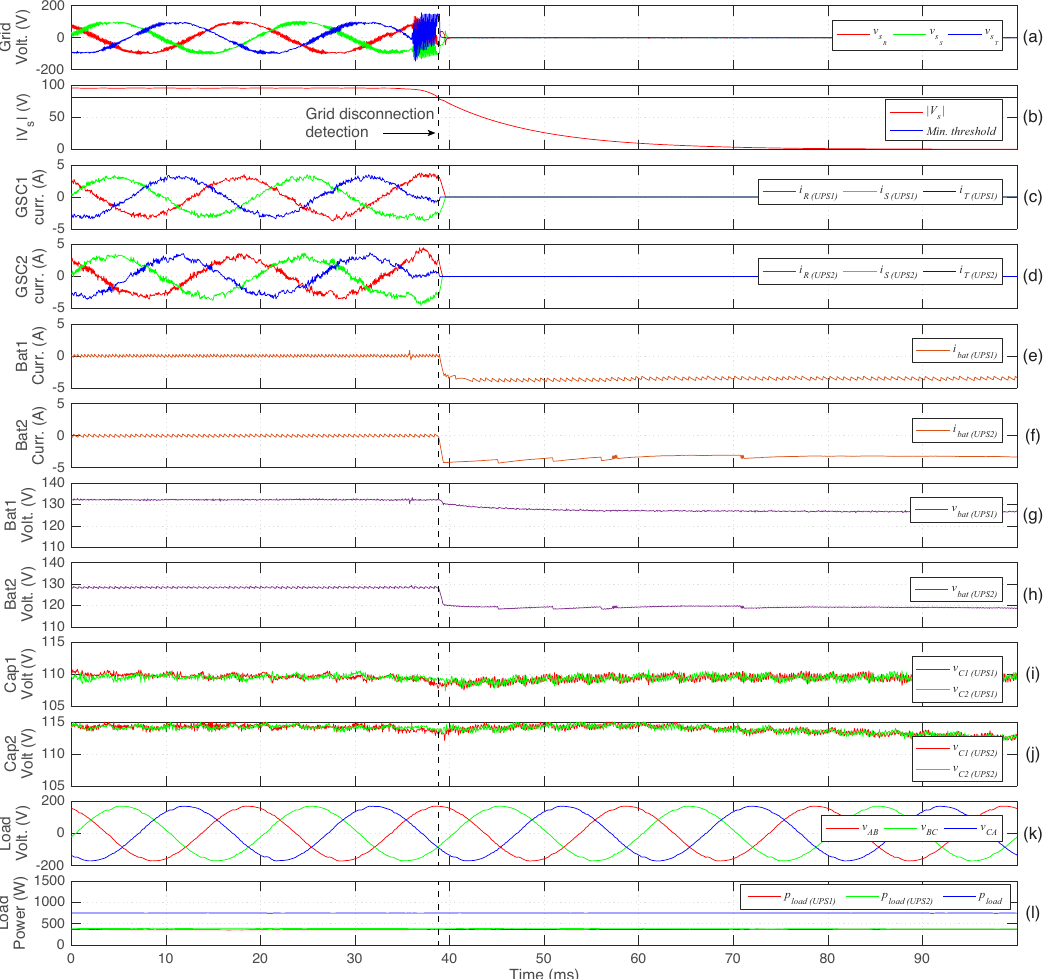
Figure 15. UPSs performance during grid disconnection: ( a ) Grid Voltage; ( b ) Grid voltage module; ( c ) UPS1 grid currents; ( d ) UPS2 grid currents; ( e ) UPS1 battery current; ( f ) UPS2 battery current; ( g ) UPS1 battery bank voltage; ( h ) UPS2 battery bank voltage; ( i ) DC bus capacitors voltage of UPS1; ( j ) DC bus capacitors voltage of UPS2; ( k ) Load Voltage; ( l ) Load power distribution and total load